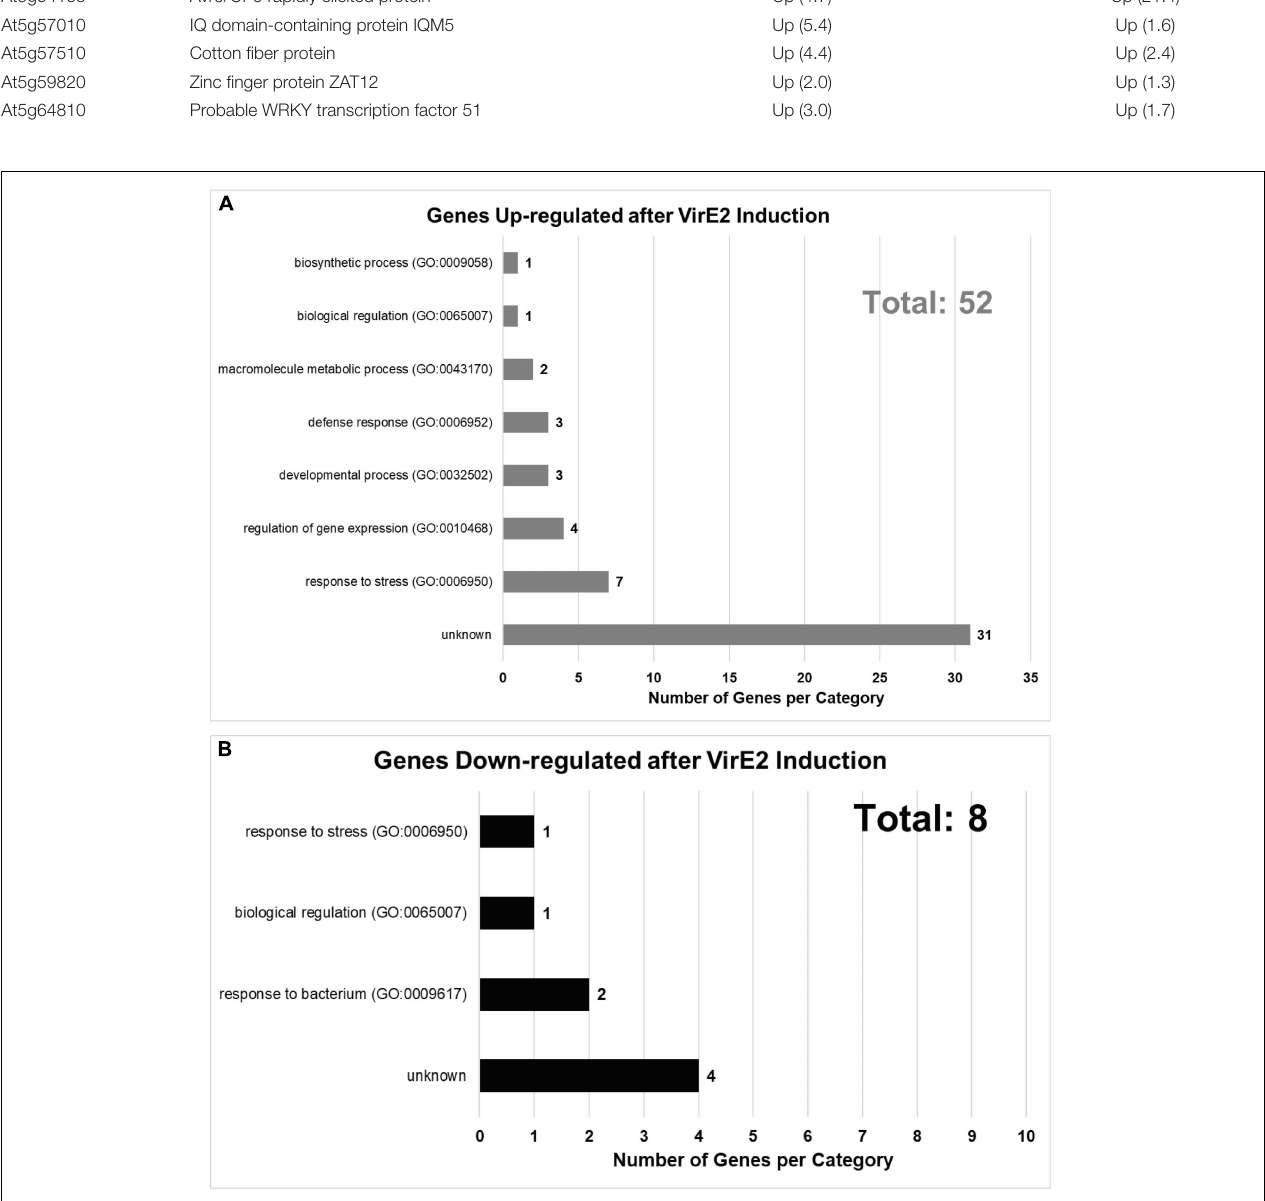
FIGURE 3 | Gene Ontology (GO) Biological Process Categories of up- (A) and down-regulated (B) genes in the presence of VirE2. Displayed are categories of genes with 1.3-fold or greater change in expression, considering all time points.